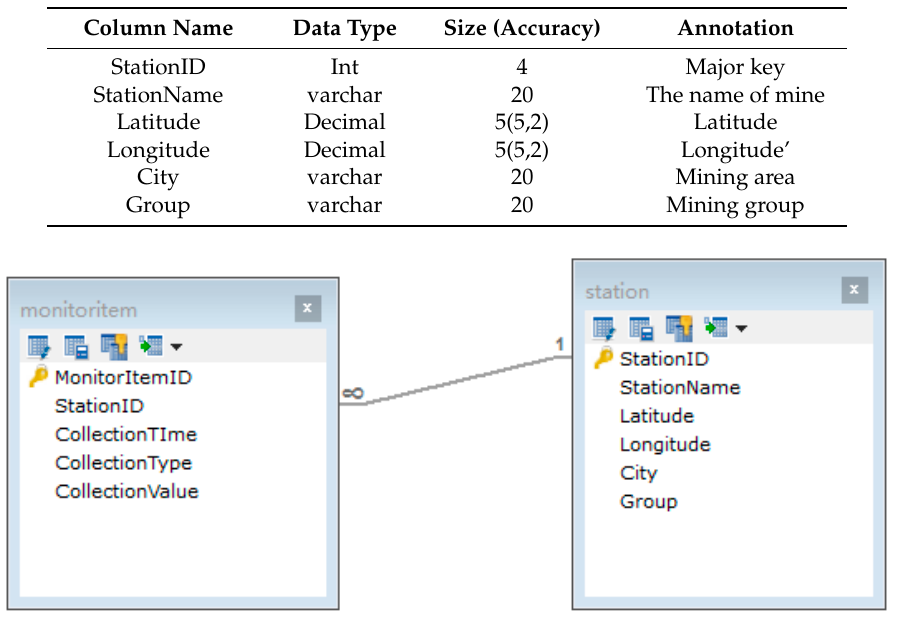
Figure 3. HAB_TP star data model.